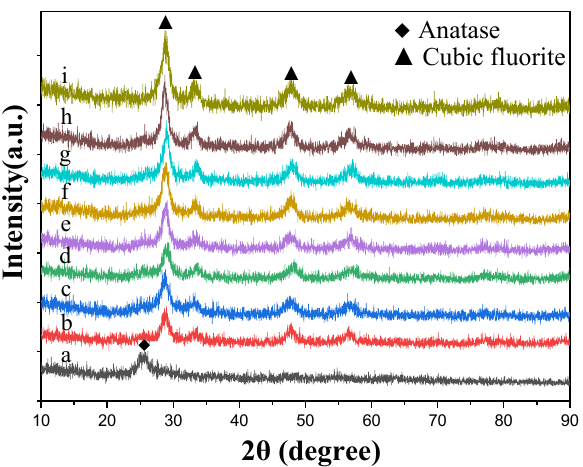
Figure 1. XRD patterns of prepared catalysts ( a : M-TSO; b : MnCeO x /M-TSO; c : K 0.1 MnCeO x /M-TSO; d : K 0.3 MnCeO x /M-TSO; e : K 0.5 MnCeO x /M-TSO; f : K 0.7 MnCeO x /M-TSO; g : K 0.9 MnCeO x /M-TSO; h : K 1 MnCeO x /M-TSO; i : K 0.5 MnCeO x /M-SiO 2 ).